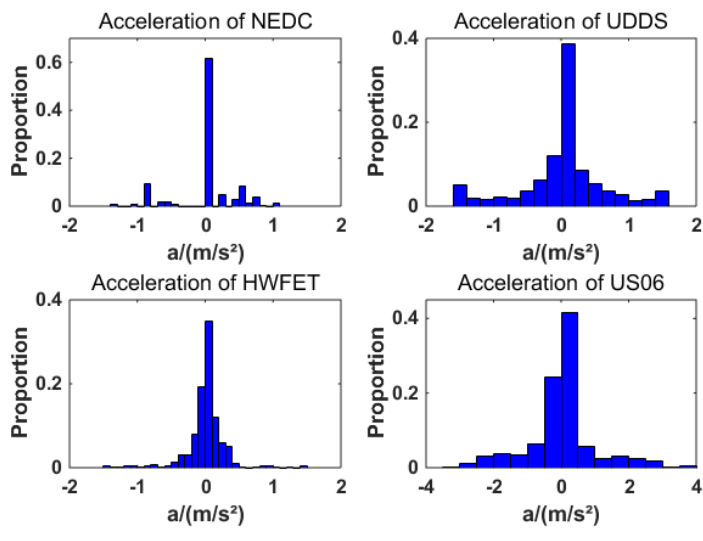
Figure 5. Four working condition acceleration values.